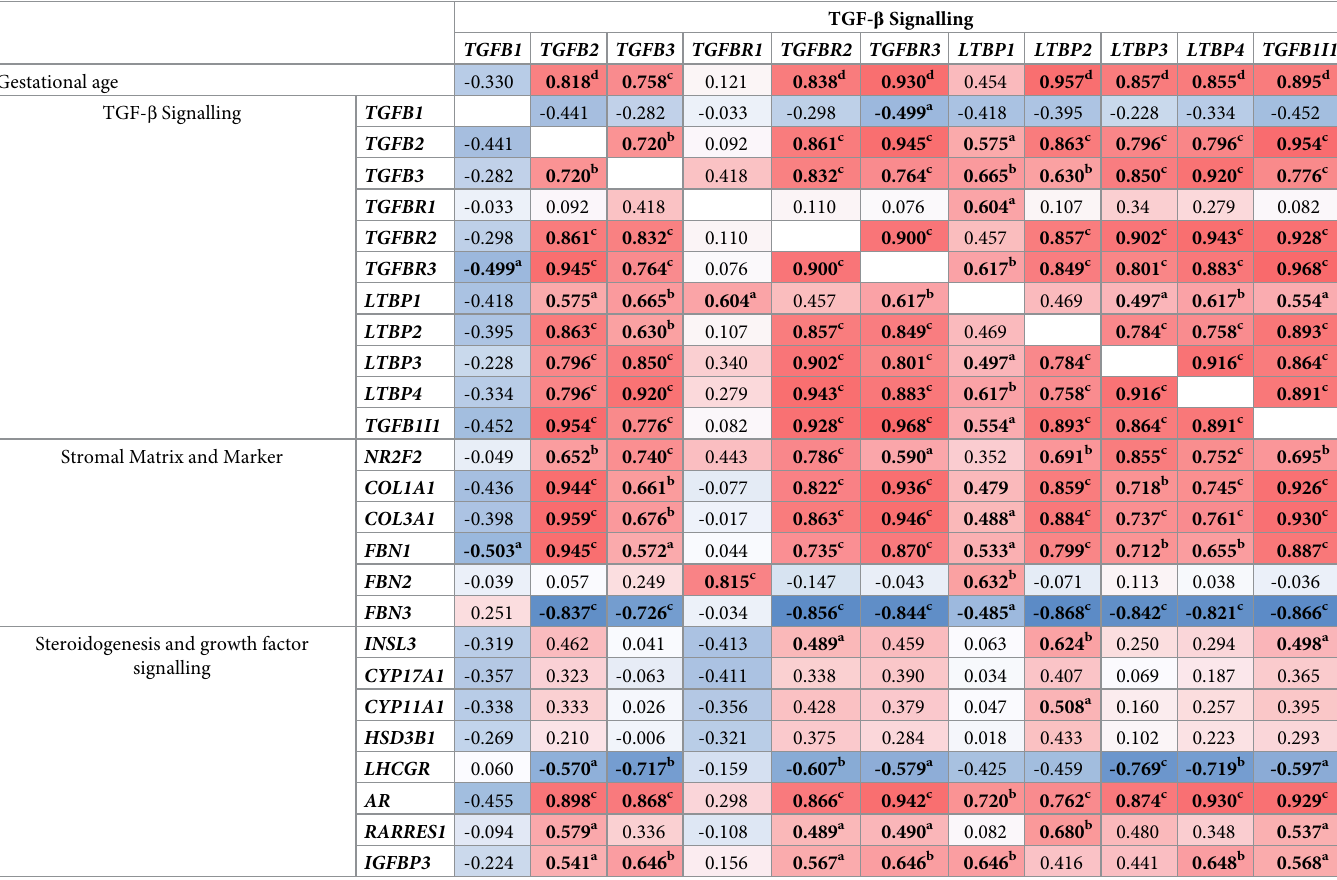
Table 1. Pearson’s correlation coefficients between expression of genes in TGF- β signalling with other genes in TGF- β signalling, stromal matrix and marker and thecal cells and gestational age. The darker the background colour the more significant the correlation is. Blue indicates a negative correlation and red indicates a positive correlation. ( P -values: a < 0.05, b < 0.01, c < 0.001, d < 0.0001).